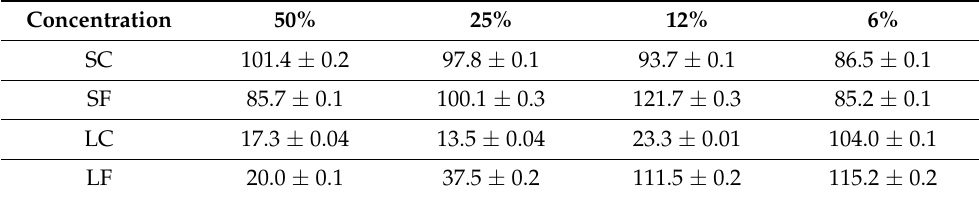
Table 1. The viability of fibroblasts exposed to the supernatants and acid lysates of allografts. Concentration